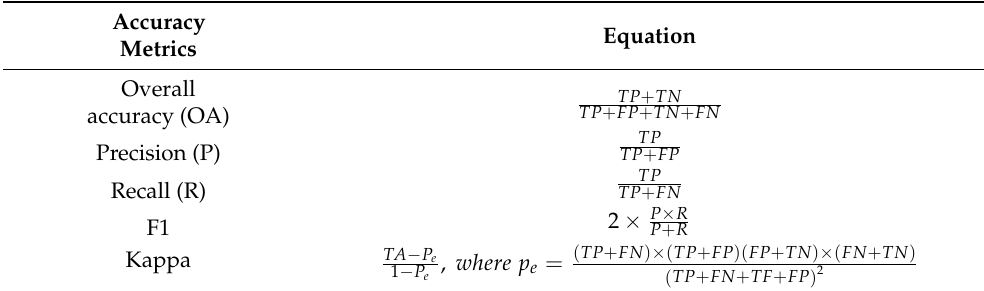
Table 2. Summary of accuracy metrics used in the object detection, where TP is true positive, TN is true negative, FP is false positive, and FN is false